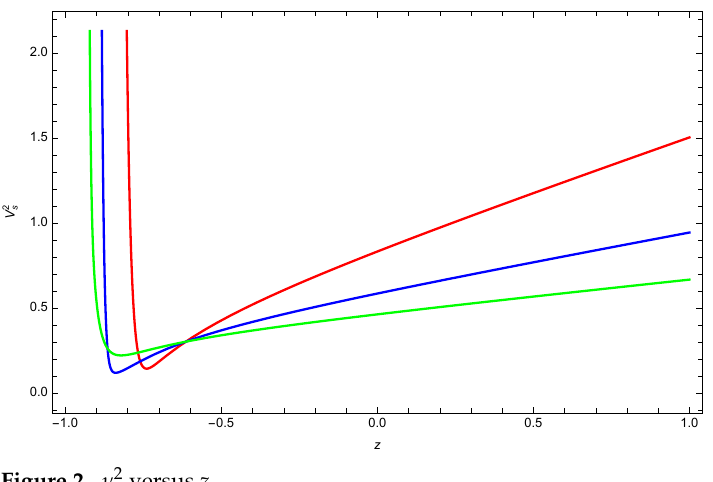
Figure 2. ν 2 s versus z .